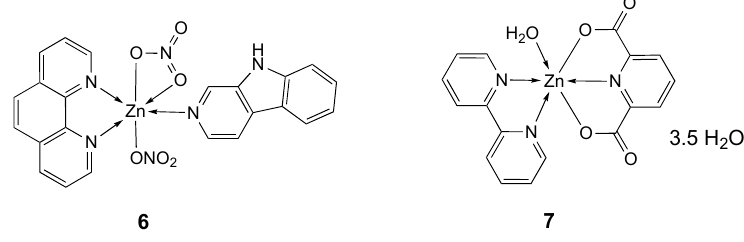
Figure 4. Structure of the zinc complexes 6 and 7 .